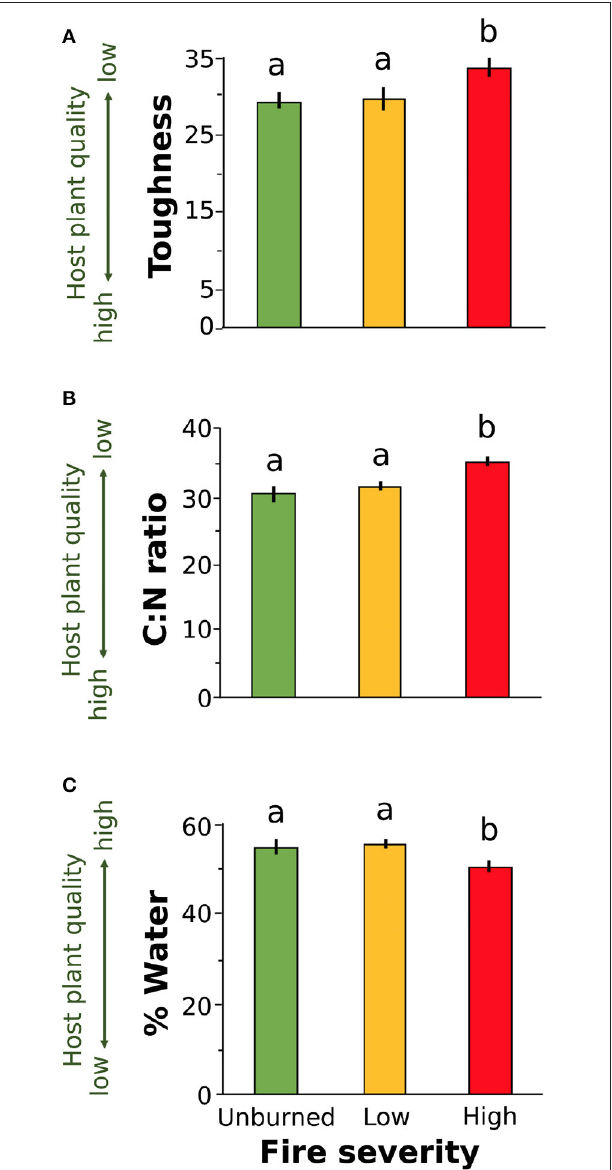
FIGURE 3 | Plant quality measures for leaves collected from wax currant plants growing in unburned, low severity, and high severity fire sites: (A) toughness, (B) carbon to nitrogen ratio, and (C) percent water. Increased leaf toughness and C:N ratio reduce host plant quality for herbivores (A,B) while increased percent water increases host plant quality (C) . Means are given ± SE and letters represent pairwise comparisons within host plant quality measure ( P < 0.05).